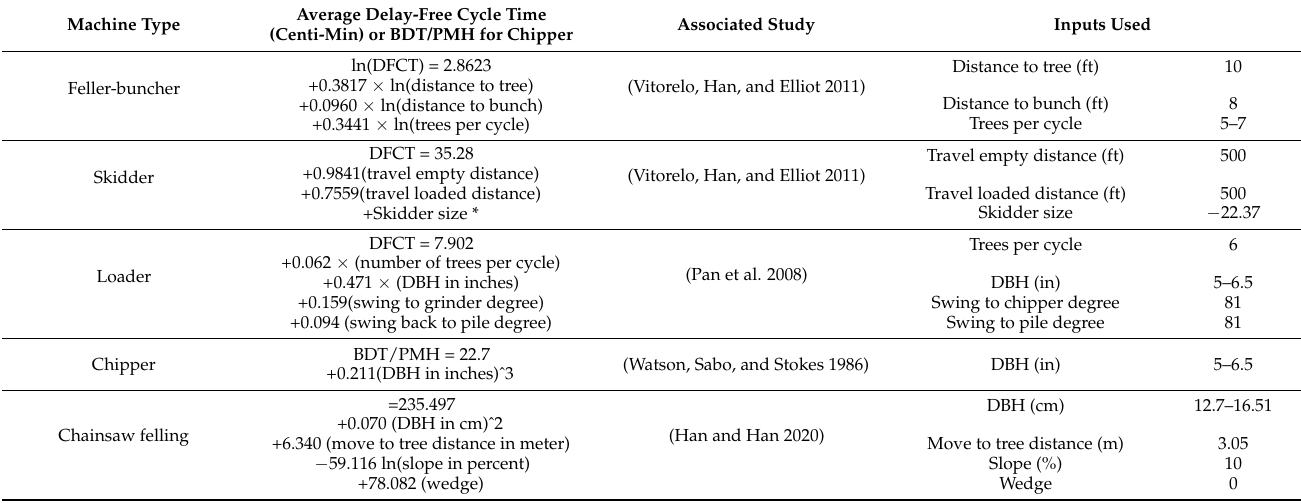
Table 4. Predictive regression equations for each